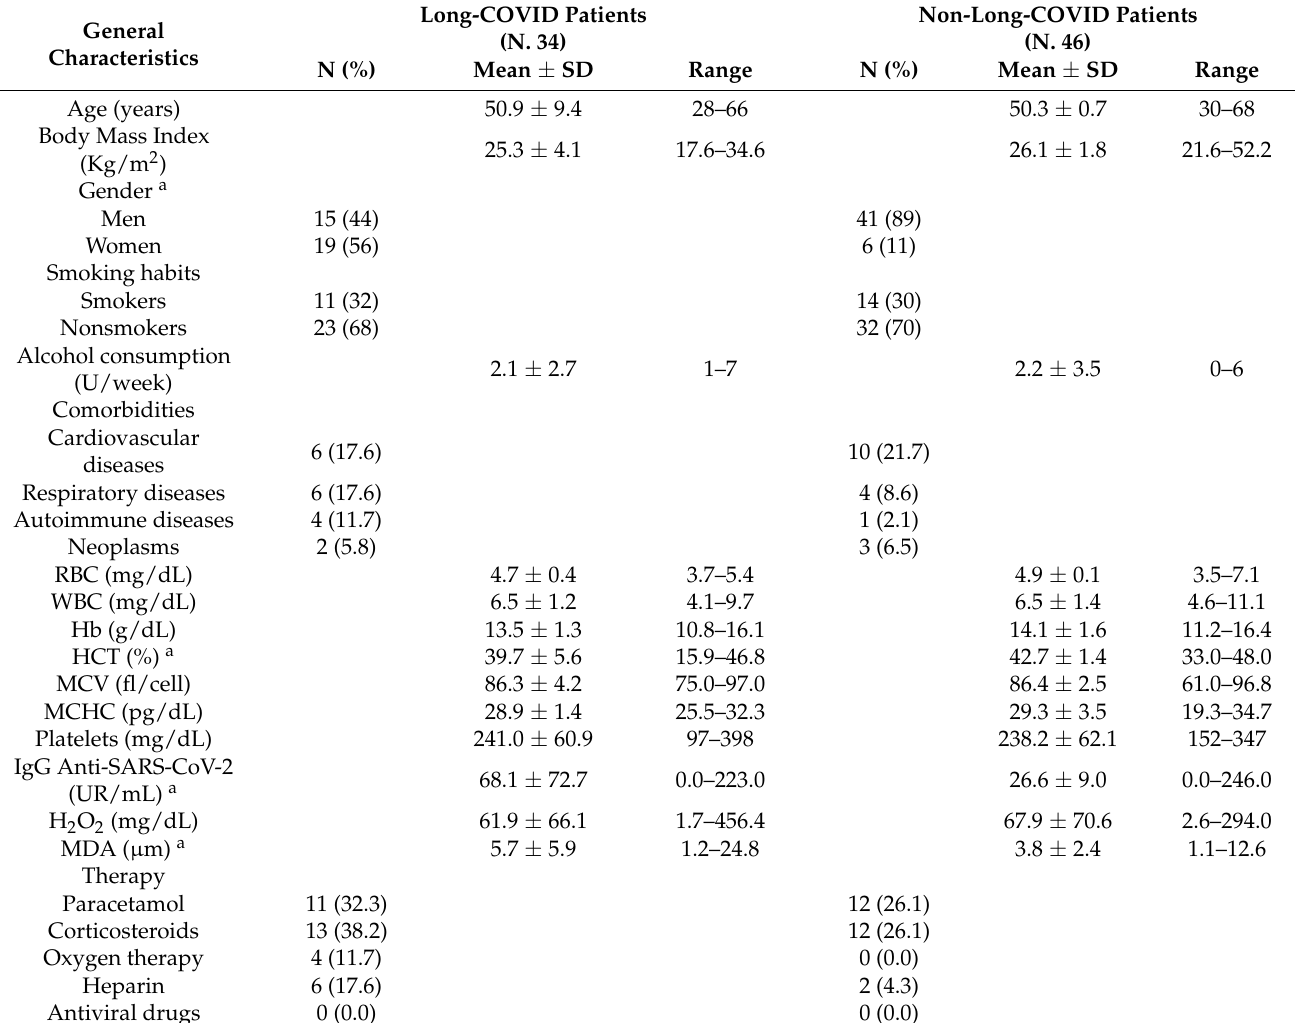
Table 2. General characteristics and clinical parameters of COVID-19 patients subdivided according to the presence (long-COVID patients) or not (non-long-COVID patients) of at least one symptom four months after